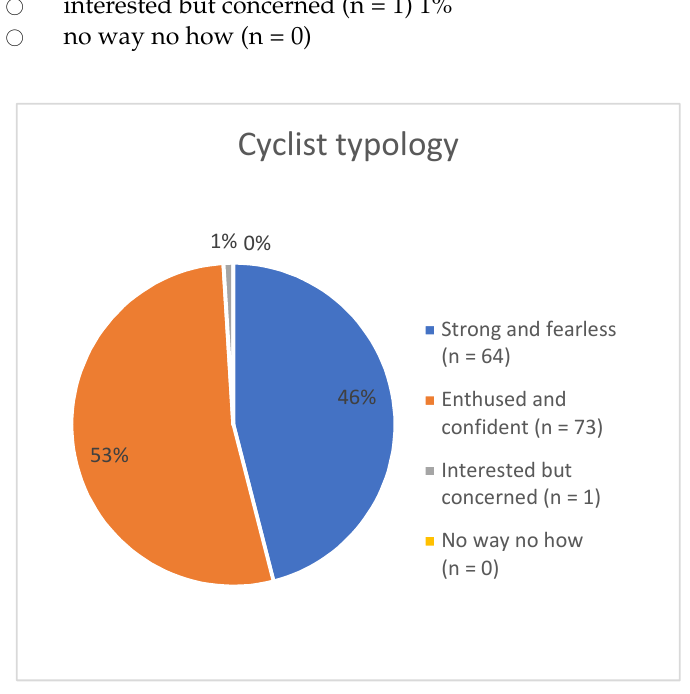
Figure 2. Cyclist typologies.